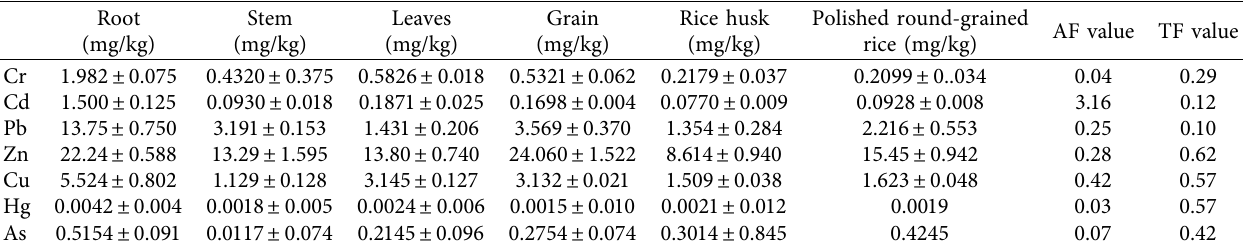
Table 3: Concentration of heavy metals of roots, stem, leaves, grain, rice husk, and polished round-grained rice.